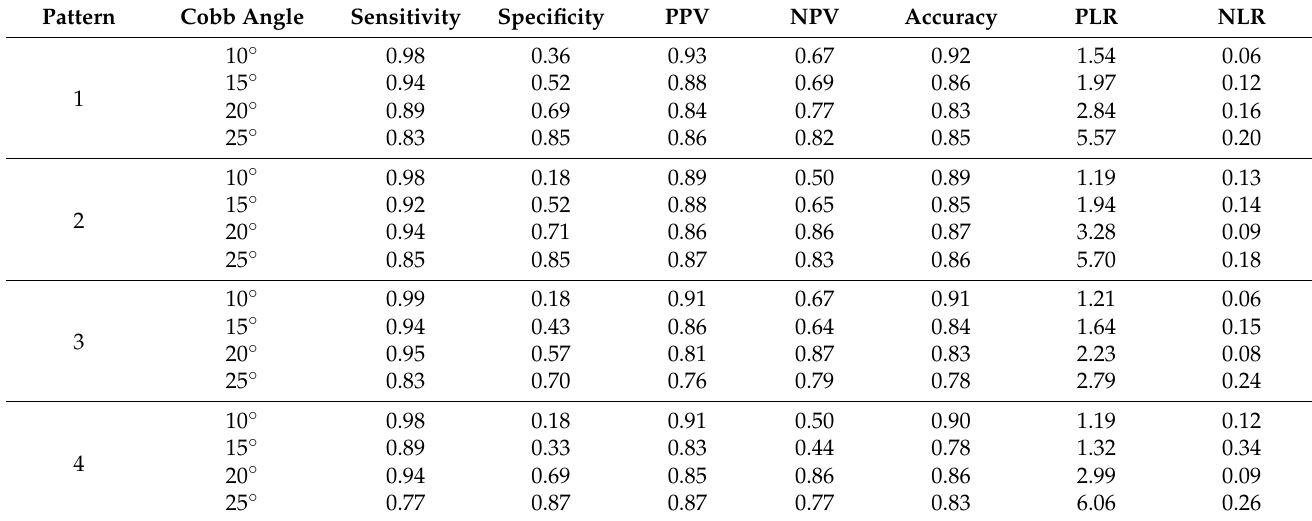
Table 5. Experimental indicators of the averaged predicted Cobb